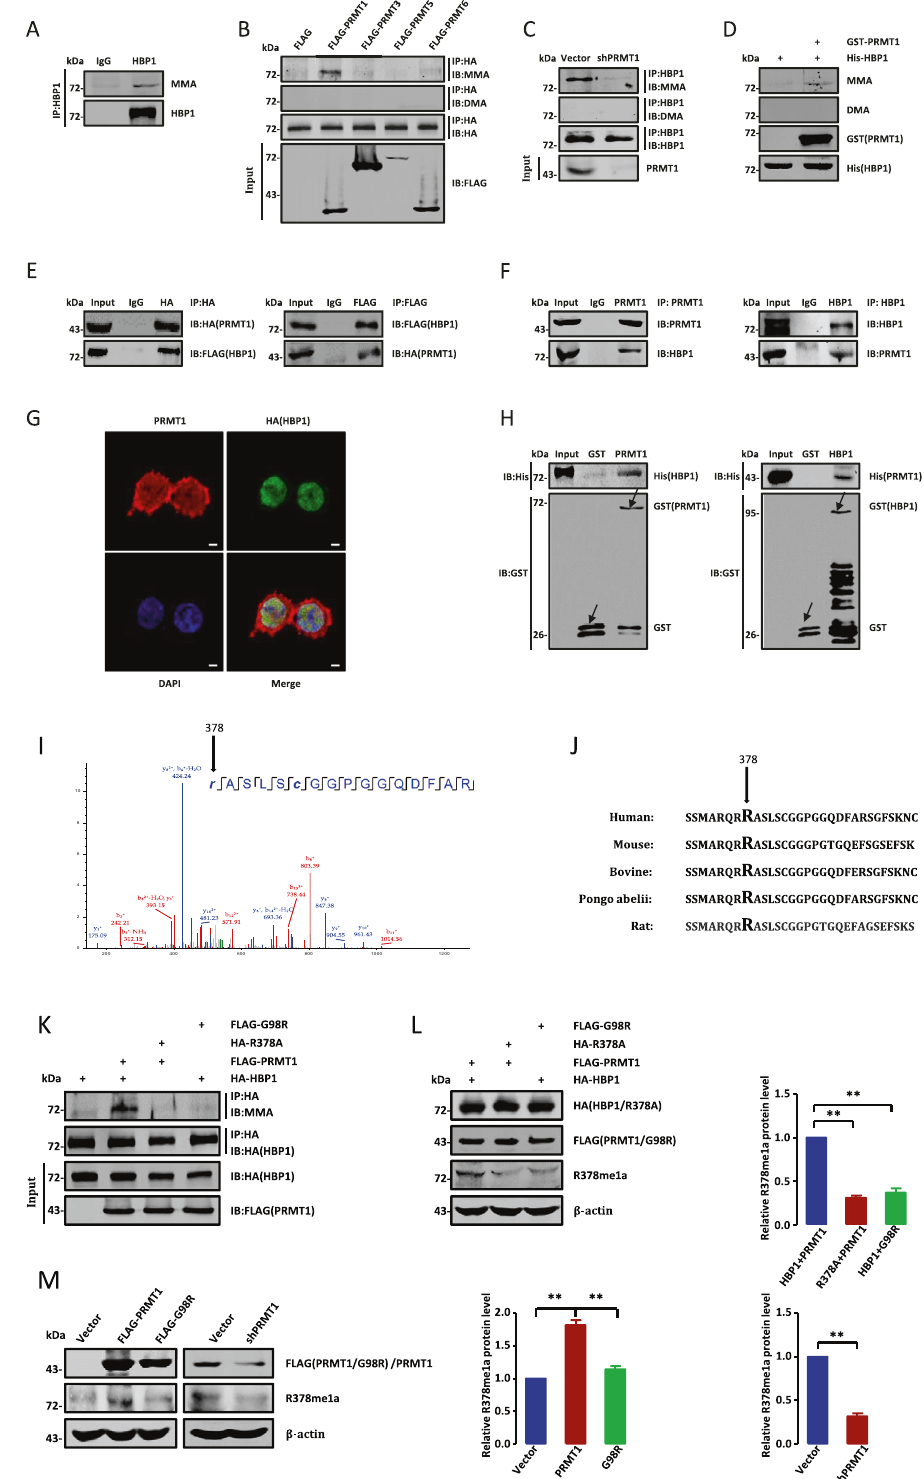
fi laments, as well as sequestering actin monomers [23]. Yet, the role of GSN in different tumors is controversial. In breast cancer and hepatocellular carcinoma (HCC), GSN promotes cell prolifera- tion and metastasis [24, 25]. However, overexpression of GSN in bladder cancer and glioblastoma (GBM) cells leads to a loss of